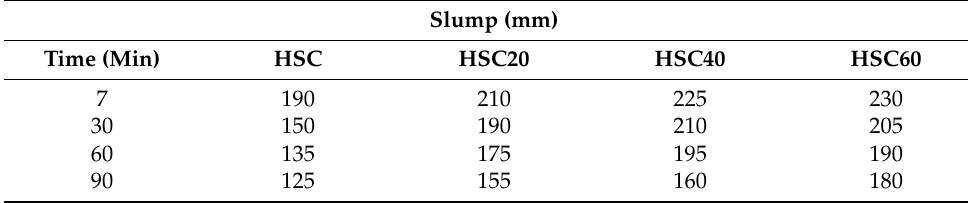
Table 7. Influence of slump loss with ultra-fine POFA